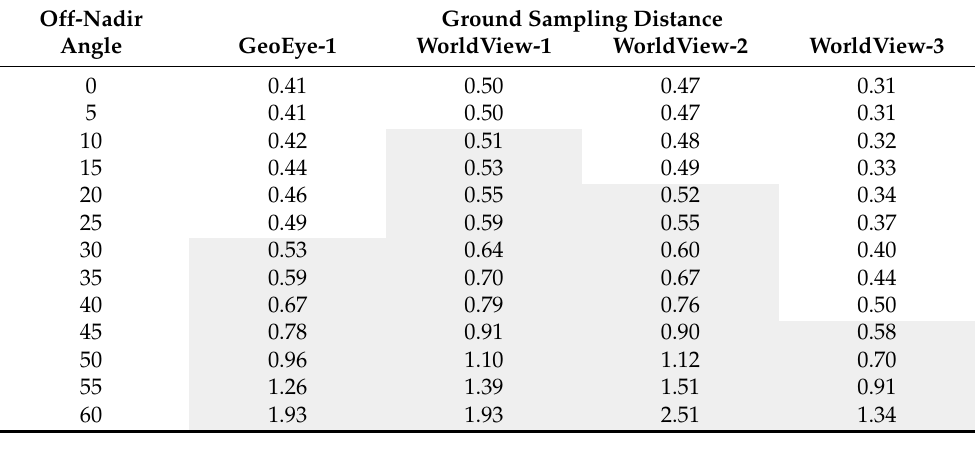
Table 3. The relationship between off-nadir angle and the ground sampling distance (GSD) by sensor for Maxar Technologies satellites. Grayed-out boxes indicate GSD > 0.50 m resolution and are therefore unlikely to be of sufficient quality for marine mammal detection. The closer the nadir angle is to zero, the higher the resolution of the resulting image collection.